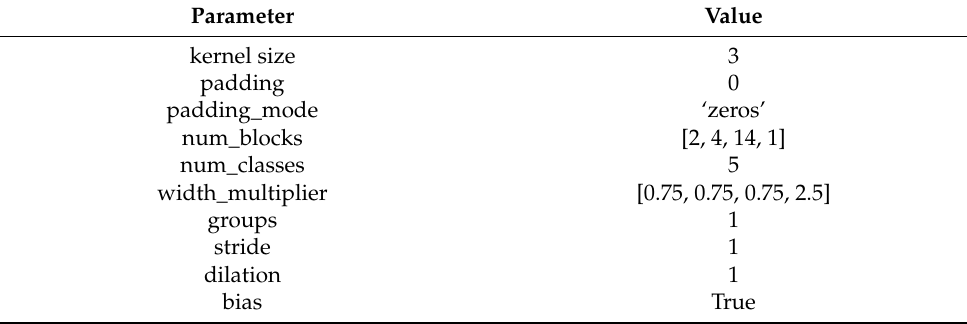
Table 3. Size of the